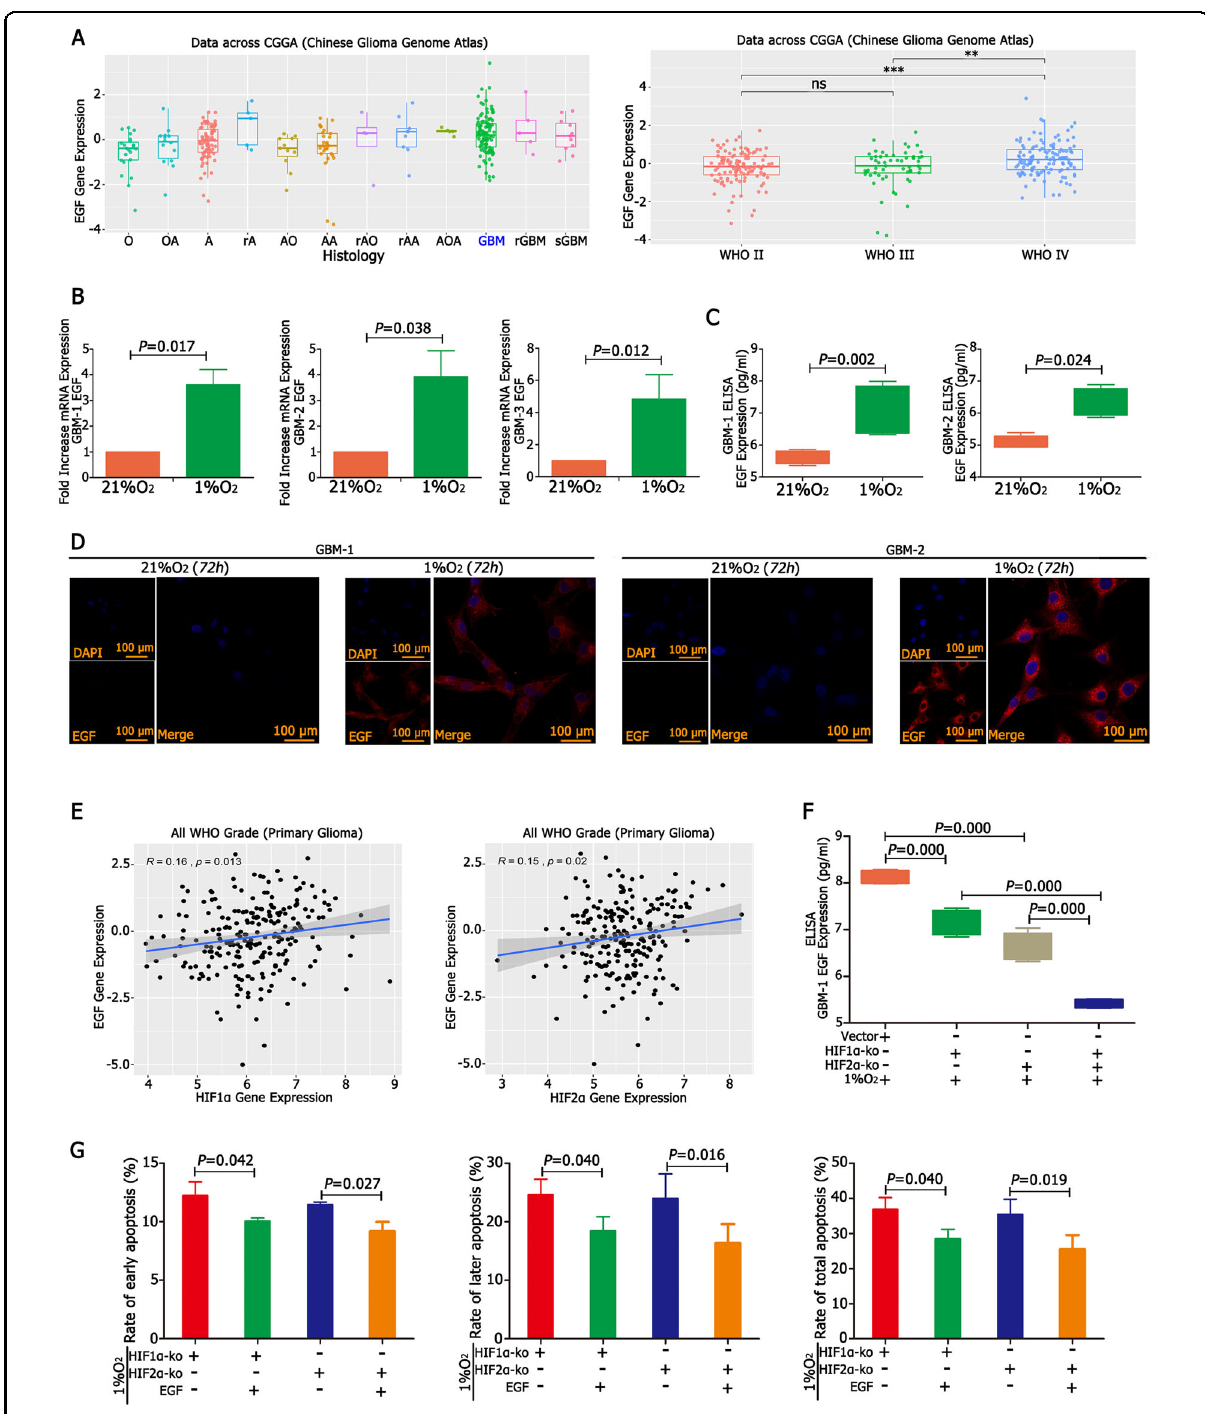
Fig. 3 HIF1 α and HIF2 α upregulated EGF in hypoxia. A EGF was highly expressed in GBM, according to the CGGA database. B GBM cells were cultured in 21% O 2 and 1% O 2 for 12 h, and EGF expression was ~3.8 – 4.6-fold higher in cells cultured in 1% O 2 than control cells cultured in 21% O 2 . C ELISA demonstrated that there were higher levels of EGF in the 1% O 2 group than in the control group. D Immuno fl uorescence showed that there was no EGF expression under normoxia; however, EGF levels increased signi fi cantly under hypoxic conditions. E Both HIF1 α and HIF2 α had a positive relationship with EGF. F After knocking out HIF1 α or HIF2 α , EGF levels decreased signi fi cantly, and EGF expression was lowest after simultaneously knocking out HIF1 α and HIF2 α . G The addition of EGF had lower early, later and total apoptosis rates in HIF1 α -KO or HIF2 α -KO cells. P values were determined by the independent samples t